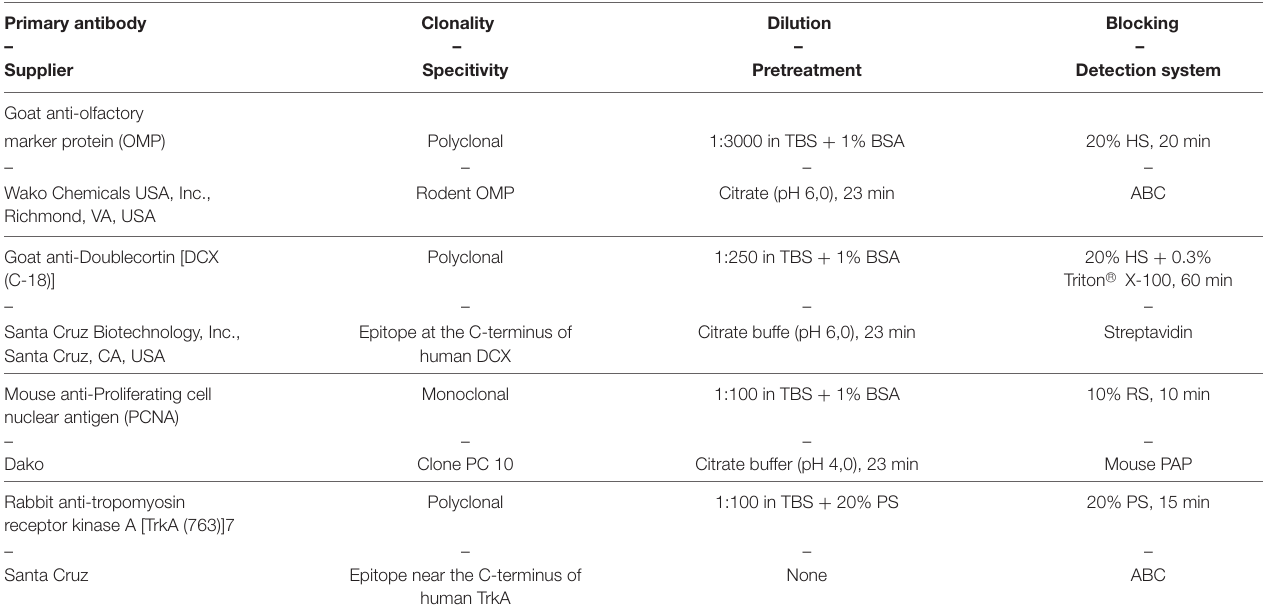
TABLE 1 | Primary antibodies, blocking, and detection system for immunohistochemistry.